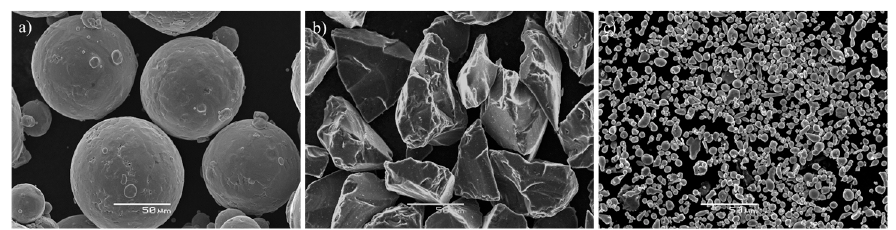
Figure 1. SEM (scanning electron microscopy) images of the raw materials: ( a ) Ti Grade 1 powders; ( b ) B 4 C powders; and ( c ) Ti-Al powders.